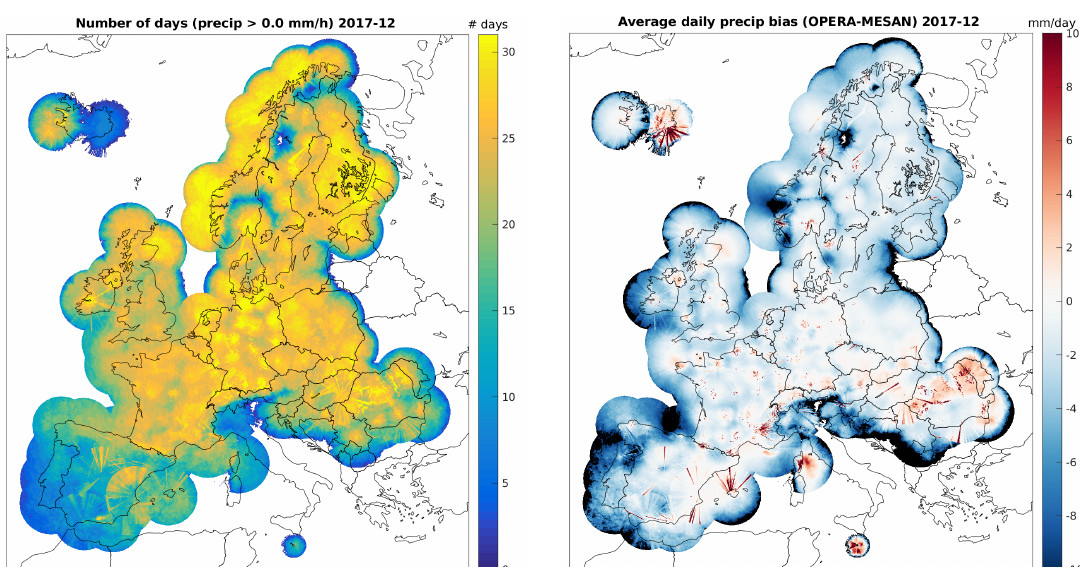
Figure 6. Number of days in December 2017 where the precipitation intensity in any of the composites was greater than 0.0 mm/h ( left ). Daily precipitation intensity bias (OPERA–MESAN), normalized by the number of days, where the precipitation intensity in any of the composites was greater than 0.0 mm/h ( right